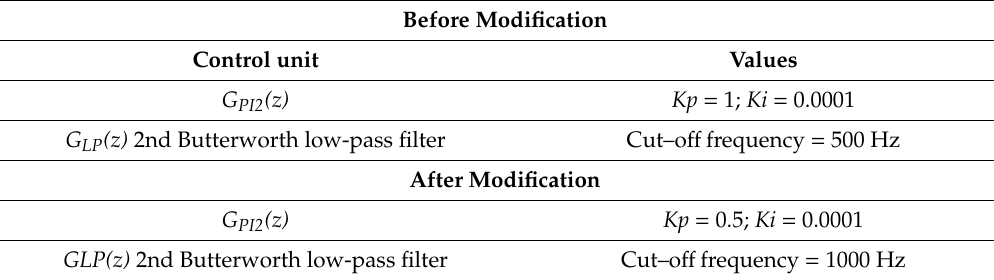
Figure 21. Experimental 75 kVA shunt active power filter prototype. Table 3. Control units of shunt APF system.